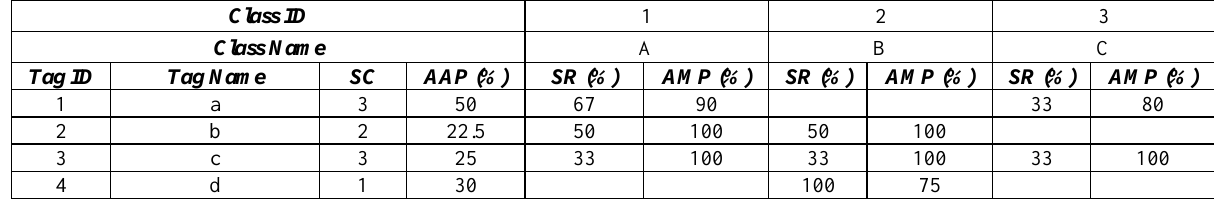
Table 1 . A schematic OSM-LULC dictionary (Total samples=3).